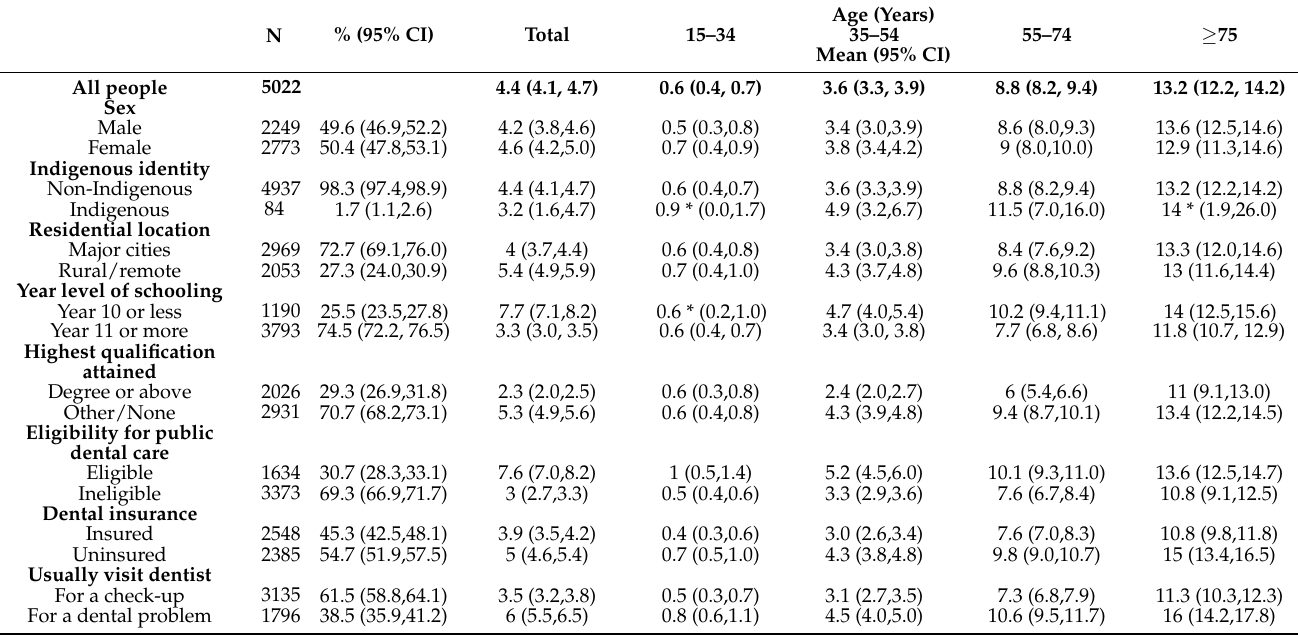
Table 7. Mean number of missing teeth for pathology per person in the Australian dentate population.